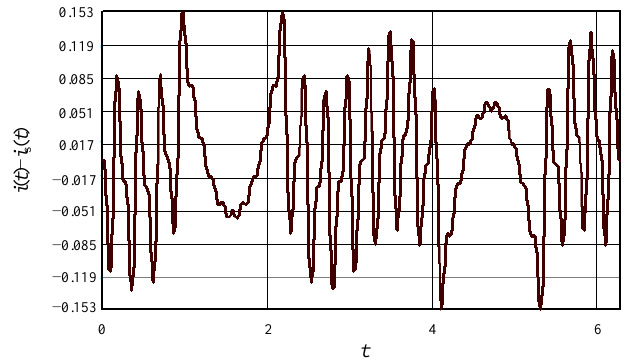
Fig. 12. The 24-pulse rectifier input current deviation from a sine